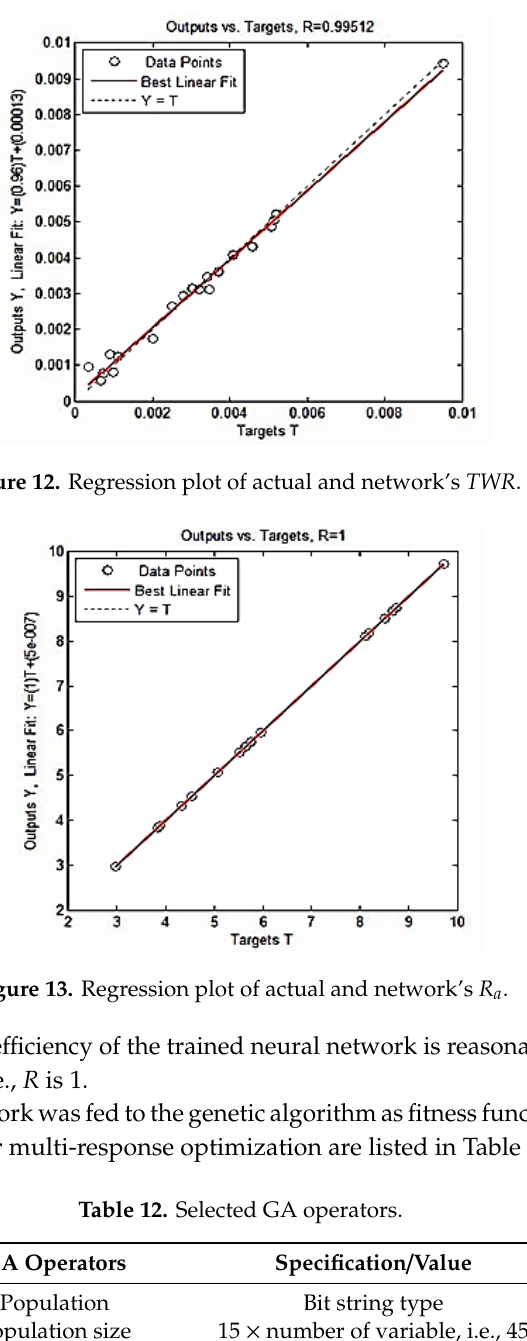
Table 12. Selected GA